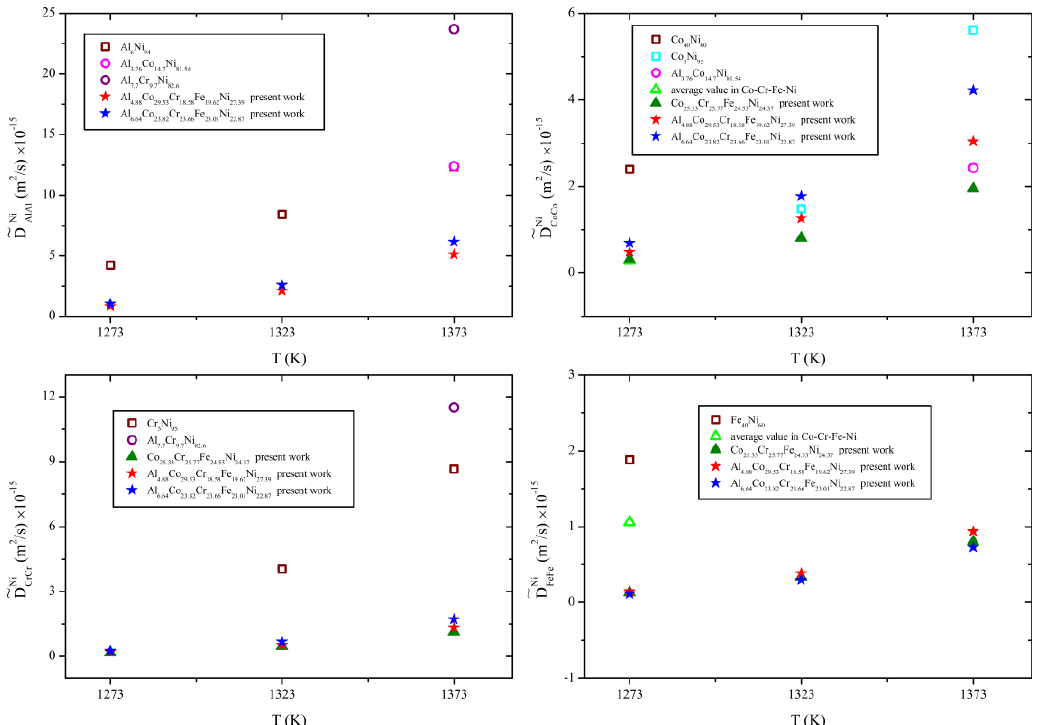
Figure 7. Comparison among the evaluated diagonal interdiffusivities for Al, Co, Cr and Fe in present work when Ni is taken as the dependent component and the literature data in the other fcc alloys: Al 6 Ni 94 [32], Al 3.76 Co 14.7 Ni 81.54 [33], Al 7.7 Cr 9.7 Ni 82.6 [34], Co 40 Ni 60 [35], Fe 40 Ni 60 [35], Co 5 Ni 95 [36], Co–Cr–